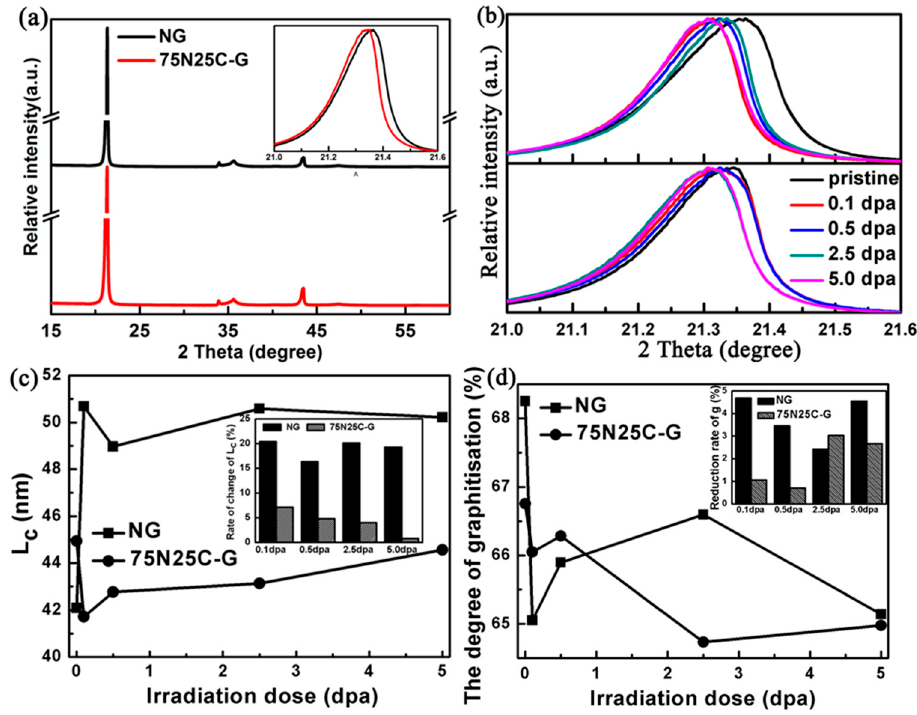
Figure 4. ( a ) GIXRD patterns of NG and 75NG25C-G; ( b ) (002) peak of irradiated NG and 75NG25C-G; ( c ) L c and ( d ) the degree of graphitization of NG and 75NG25C-G as functions of irradiation dose.